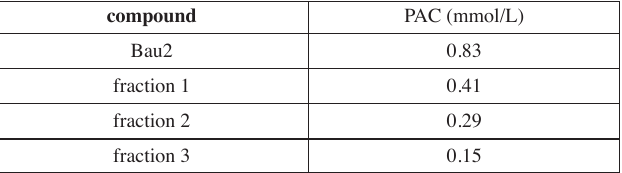
Tab. 7: Proanthocyanidin (PAC) content of Bau2 and corresponding sepha - dex fractions, estimated as cyanidin equivalents by absorbance at 540 nm after boiling in Butanol/HCl for 20